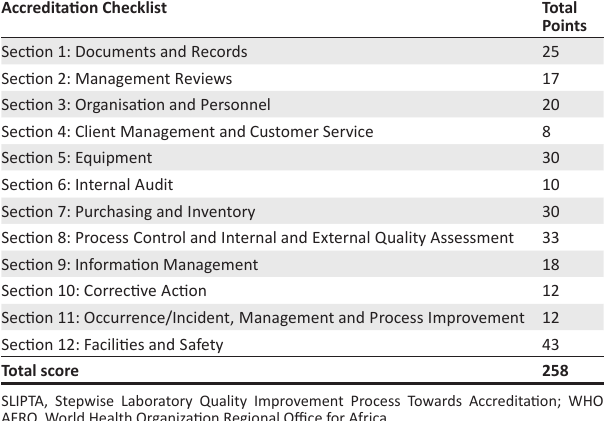
TABLE 1: SLIPTA scoring system for laboratories.